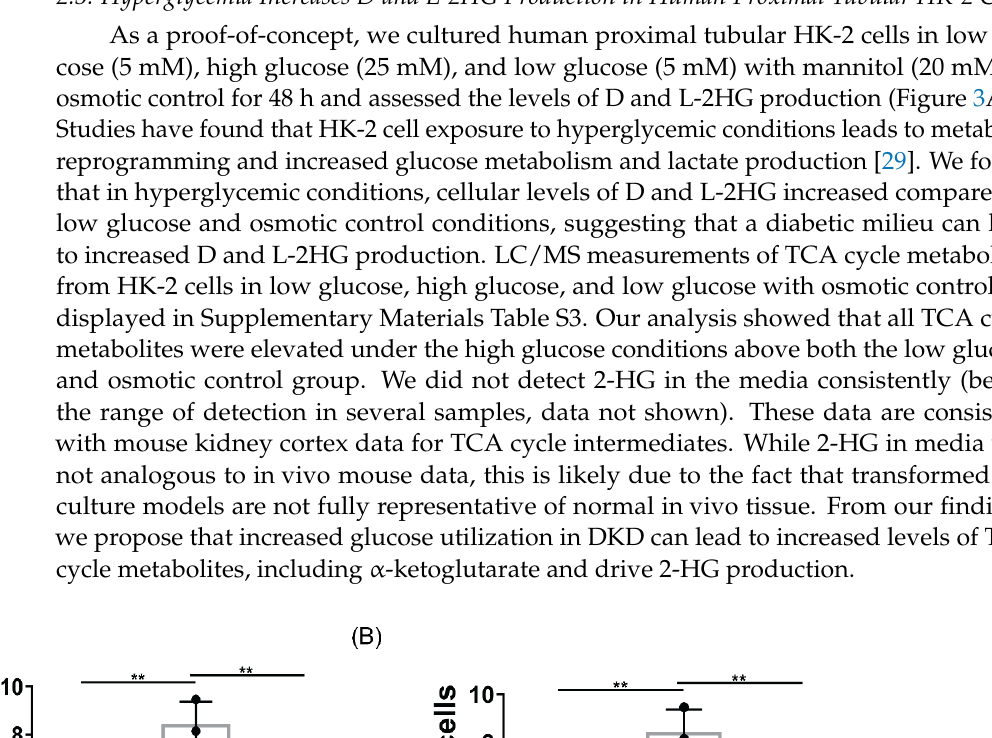
Figure 2. Kidney cortex levels of TCA cycle metabolites drive D and L-2HG production. ( A ) Schematic of TCA cycle with fold change (Control db / + vs. diabetic db / db ) denoted (red if p ≤ 0.05 and black if did not meet significance). Metabolites in gray were not measured in the study. *: Citrate and isocitrate were measured as one transition. ( B ) Western blot of db / + and db / db cortex for D-2HGDH, L-2HGDH, and VDAC ( n = 4). Figure 2A was created with BioRender.com.